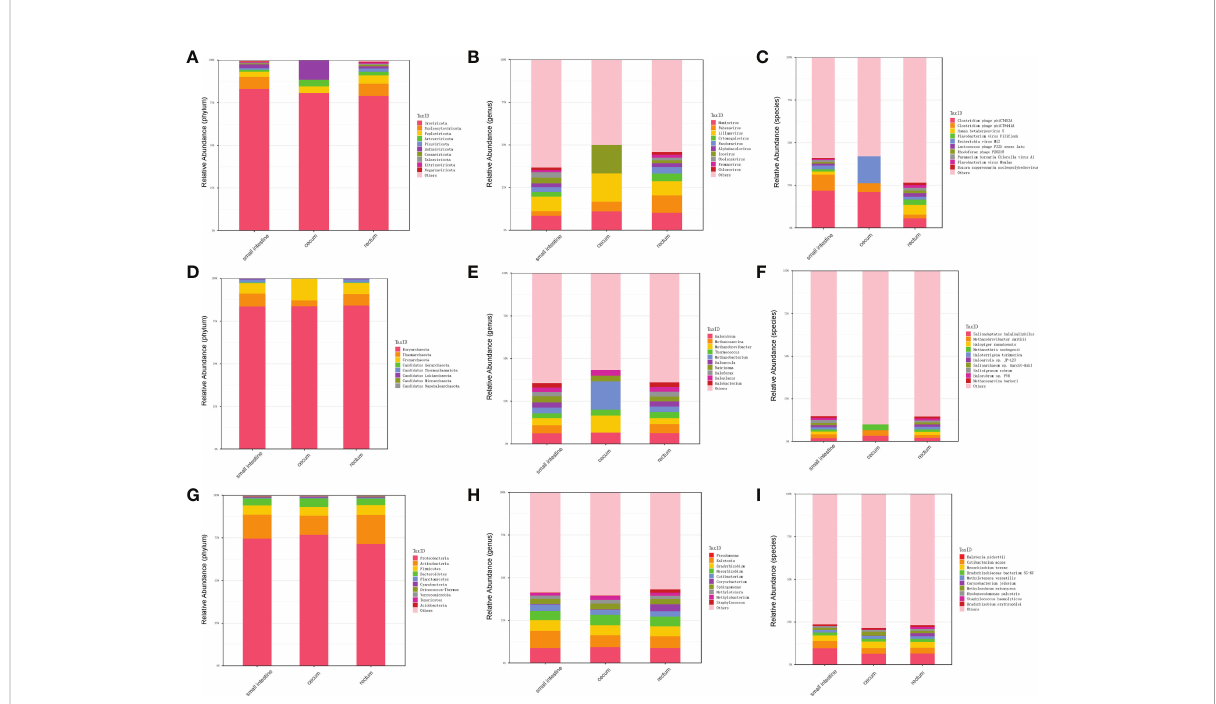
FIGURE 3 Distribution of microbiota in different parts of fetal gut detected by virome. (A) The top 10 abundant virus phyla in three different parts of fetal gut. (B) The top 10 abundant virus genera in three different parts of fetal gut. (C) The top 10 abundant virus species in three different parts of fetal gut. (D) The top 10 abundant archaea phyla in three different parts of fetal gut. (E) The top 10 abundant archaea genera in three different parts of fetal gut. (F) The top 10 abundant archaea species in three different parts of fetal gut. (G) The top 10 abundant bacteria phyla in three different parts of fetal gut. (H) The top 10 abundant bacteria genera in three different parts of fetal gut. (I) The top 10 abundant bacteria species in three different parts of fetal